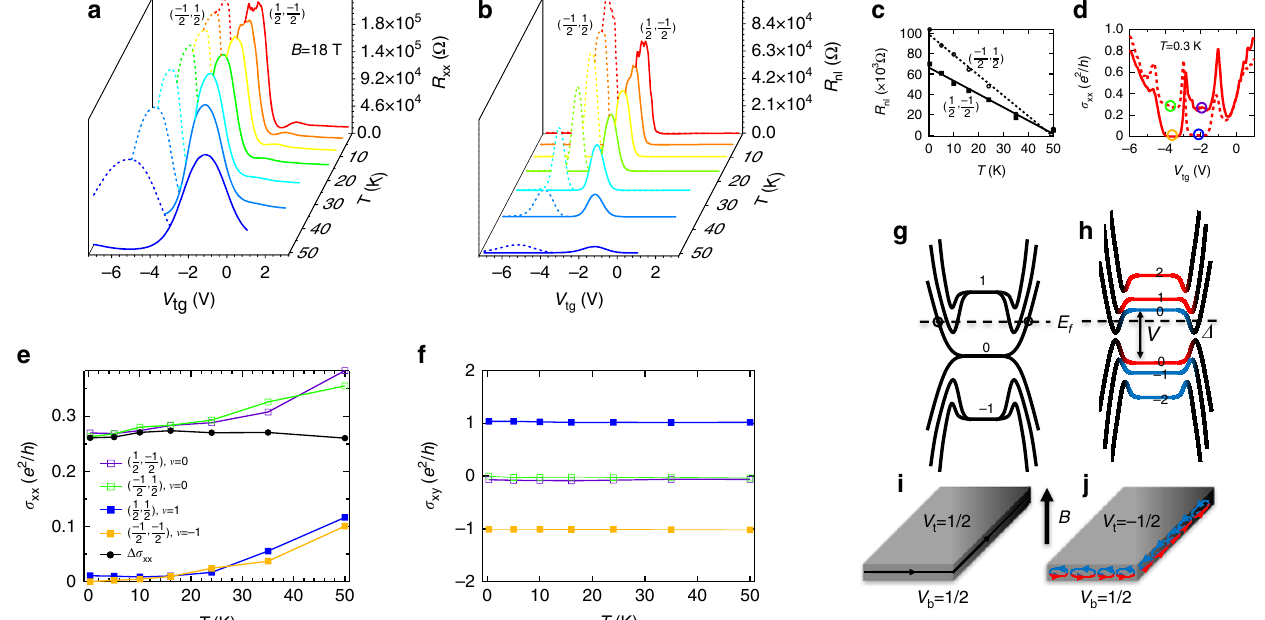
Figure 4 | Temperature dependence and illustrative schematics of the QHE and v ¼ 0 state in TI. ( a ) R xx and ( b ) R nl measured in sample ‘A’ as functions of V tg for different temperatures at B ¼ 18T, where V bg is chosen to set n b at 1/2 (dashed lines) and (cid:2) 1/2 (solid lines), respectively. ( c ) The R nl value at ( n t , n b ) ¼ ( (cid:2) 1/2, 1/2) and (1/2, (cid:2) 1/2) shows approximately linear dependence on temperature. ( d ) s xx versus V tg (with the same two values of V bg chosen in a and b) at T ¼ 0.3K as an example, with each highlighted circle corresponding to a state in e plotted with corresponding coloured symbols. ( e ) s xx and ( f ) s xy of n ¼ þ 1, (cid:2) 1 and 0 states as functions of temperature. In e , we also plot Ds xx (difference between averaged n ¼ 0 states’ s xx and averaged n ¼ ± 1 states’ s xx ), which barely changes with T . ( g , h ) Schematics of surface band structure (energy spectrum) in high magnetic field, showing LLs from top and bottom surfaces (blue and red) in the middle of the sample transitioning into side surface sub-bands at sample edge, and ( i , j ) edge states in a slab-shaped sample for n ¼ 1 and n ¼ 0 states. The dashed line indicates a representative Fermi level E f and circles in g label chiral edge modes. NATURE COMMUNICATIONS|7:11434|DOI: